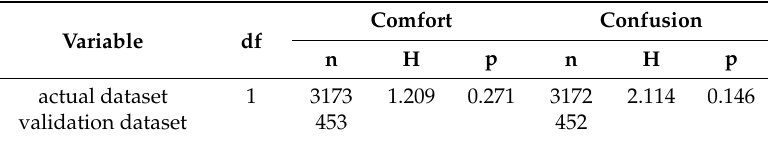
Table 2. Kruskal-Wallis H for the actual and validation dataset. Comfort Variable df